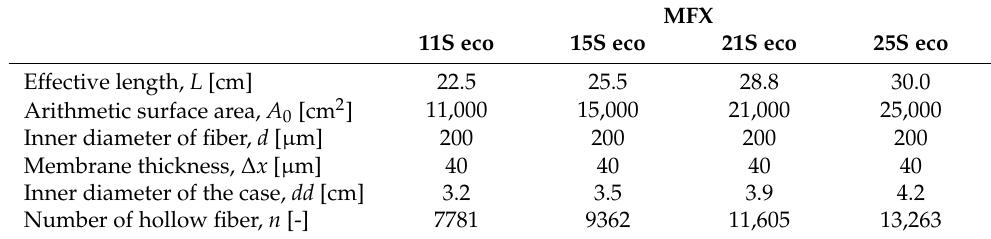
Table 2. Technical specifications of MFX-S eco